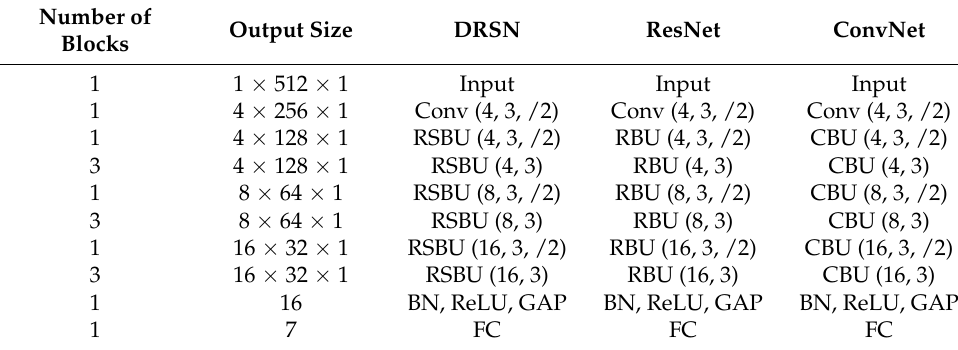
Table 3. Structural parameters of the three